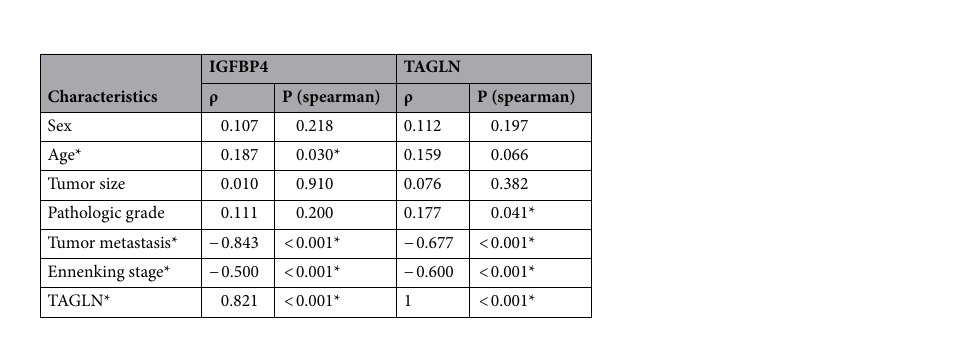
Table 2. The corelationship between characteristics of patients and IGFBP4 and TAGLN. Spearman-rho test was used. *P < 0.05.